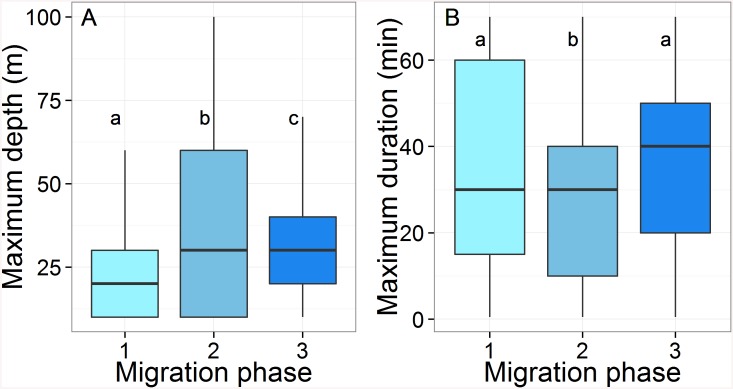
Box plots of (A) the maximum depth (m) and (B) the maximum duration (min) recorded by the 14 Argos-Fastloc GPS tags during the three migration phases.The box plots sharing the same letter are not statistically different (Tukey HDS). The horizontal black line in box plots represents the median.